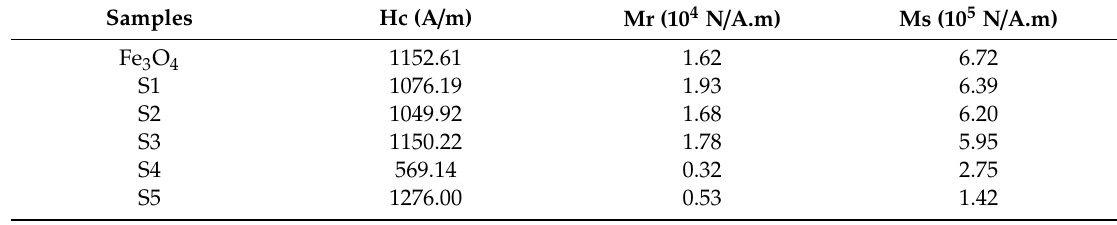
Figure 7. The magnetization curves of Fe 3 O 4 and EG/ Fe 3 O 4 ( a ) and an expanded view of the low-field magnetization curves ( b ).